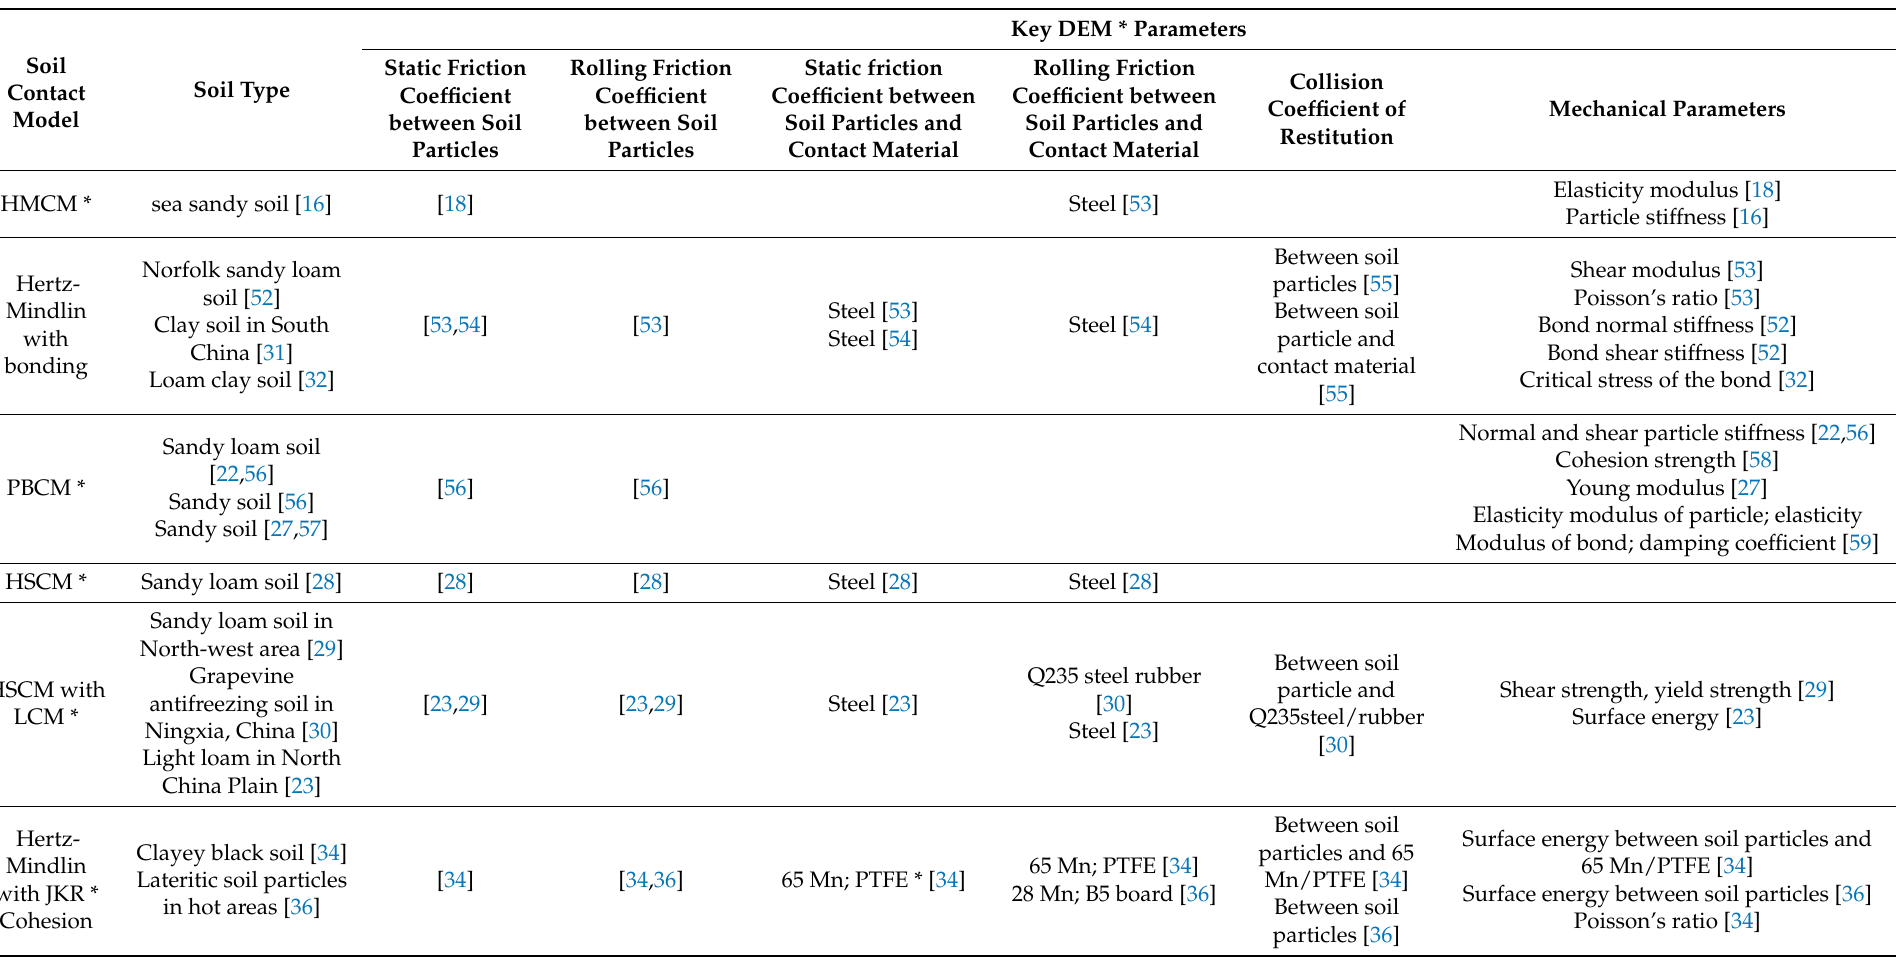
Table 1. Common DEM models and key parameters of